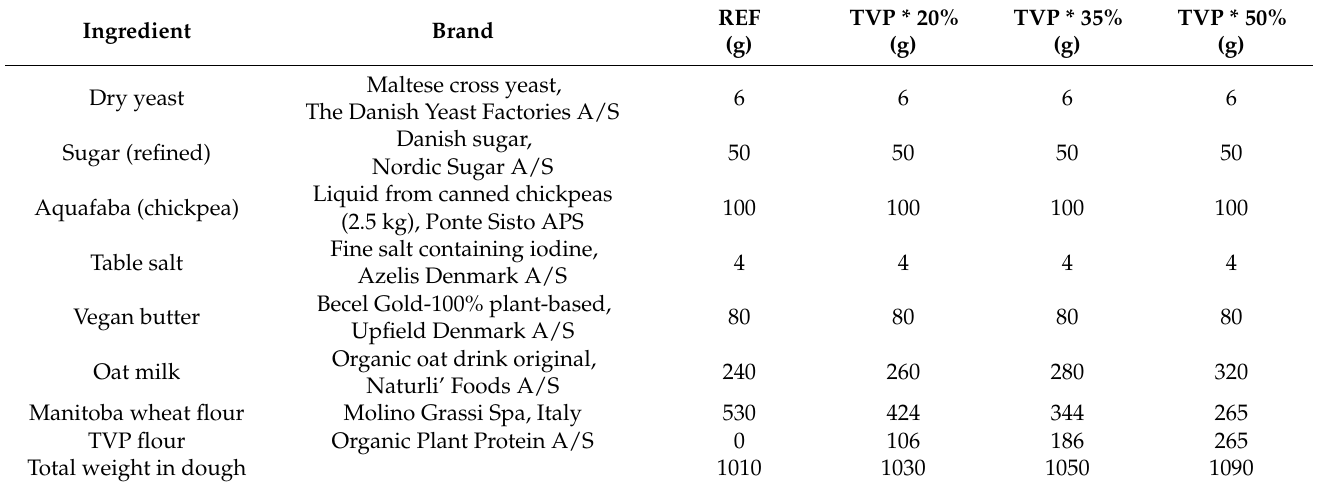
Table 1. Recipe for buns with or without